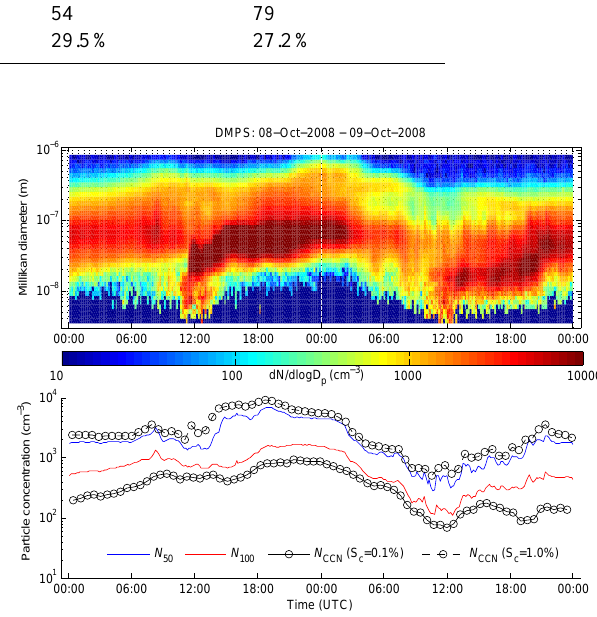
Fig. 3. An example of a nucleation event in Hyyti¨al¨a station on May 30, 2009. The top panel depicts the time series of particle number size distribution. The bottom panel shows the corresponding time series of two DMPS-derived CCN concentrations ( N 50 and N 100 ) and two CCN concentrations N CCN measured by the CCNC at two supersaturation (S c ) levels of 0.1% and 1.0%.